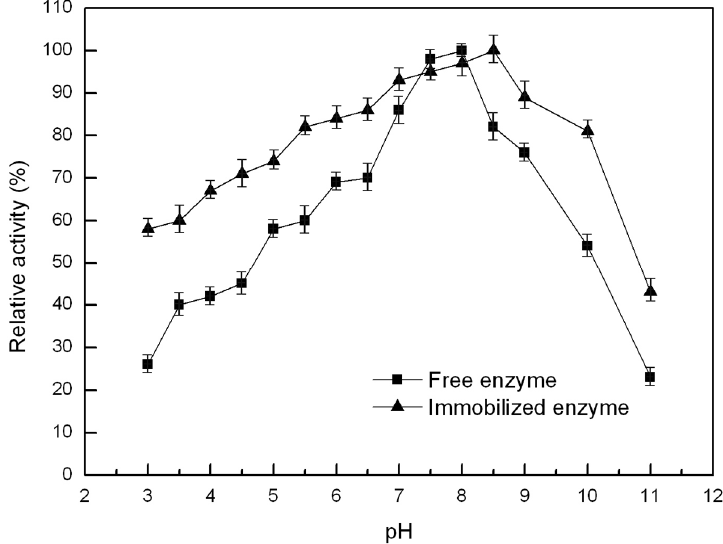
Figure 7. The effect of pH on the free and immobilized enzyme.